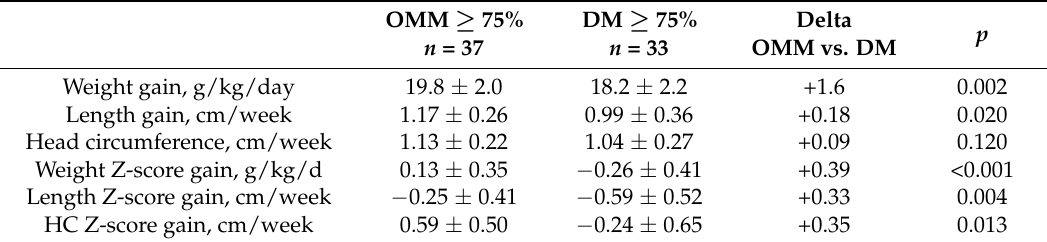
Table 3. Growth rate and Z-score gain in preterm infants fed individualized fortified with predominantly own mother’s milk (OMM) or donor milk (DM.)